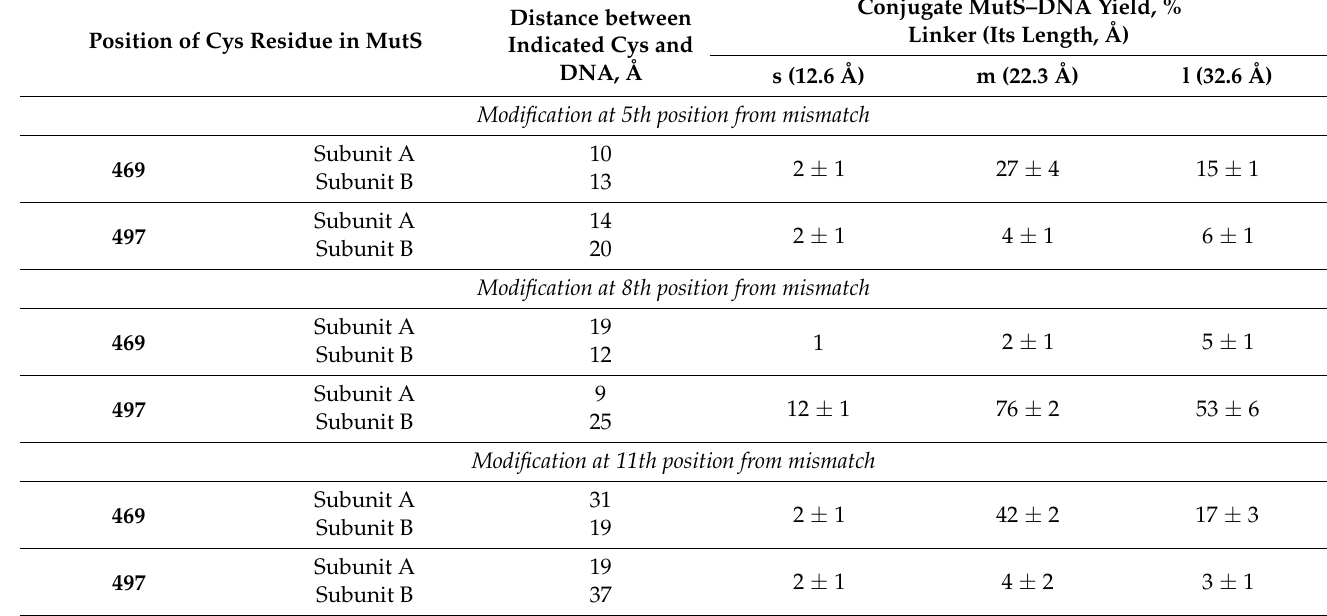
Table 1. Calculated distances from the SG atom of Cys469 or Cys497 in MutS to C5 of dU at some positions in DNA and the yield of MutS–DNA